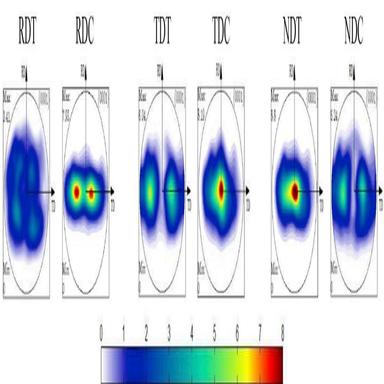
The predicted pole figures after 20% tension/compression along six directions, when only Py is activated in the thought experiment, show a significant anisotropy and asymmetry.